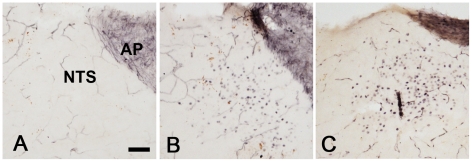
Brain activation in response to rotavirus infection.Coronal sections from the lower brainstem of a non-infected pup (A) and pups 48 h after RV infection (B, C). Note that many cells in the NTS of the infected animals display immunoreactivity for the activity marker Fos. AP; area postrema. Bar represents 50 µM.